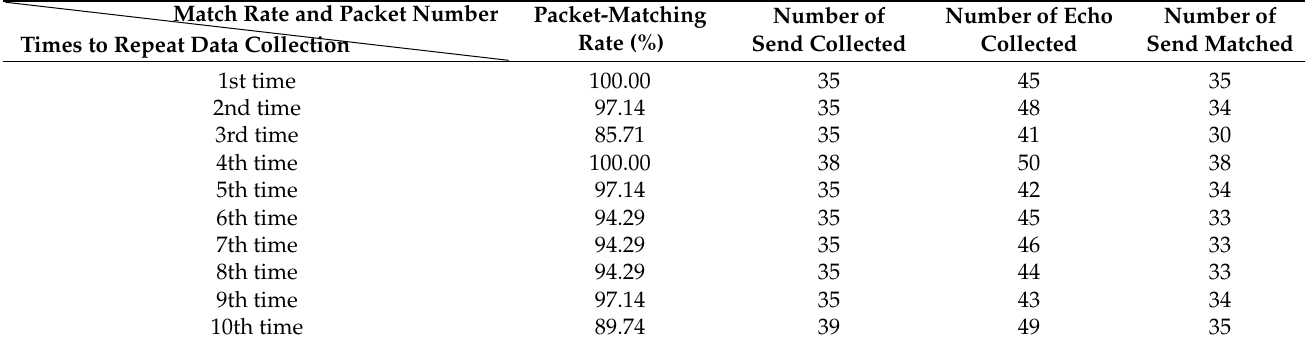
Table 3. Packet-matching rate in three-connection (average rate: 94.97%).